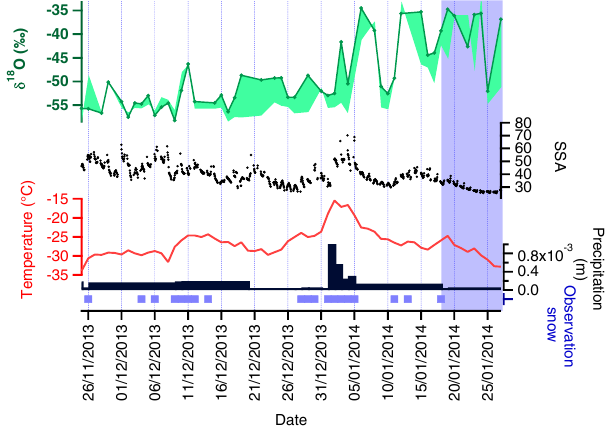
Figure 7. Comparing the surface and subsurface snow isotopic compositions at Dome C: surface isotopic composition (green line) and difference between surface and the subsurface (green shade; for more details, see Table 2); with SSA measurements (black dots), 2m temperature (red line) and precipitation (black bars) from ERA- Interim, as well as precipitation observations (blue squares). The vertical bar shows the period during which the grain index changes reflect large metamorphism (see Sect.